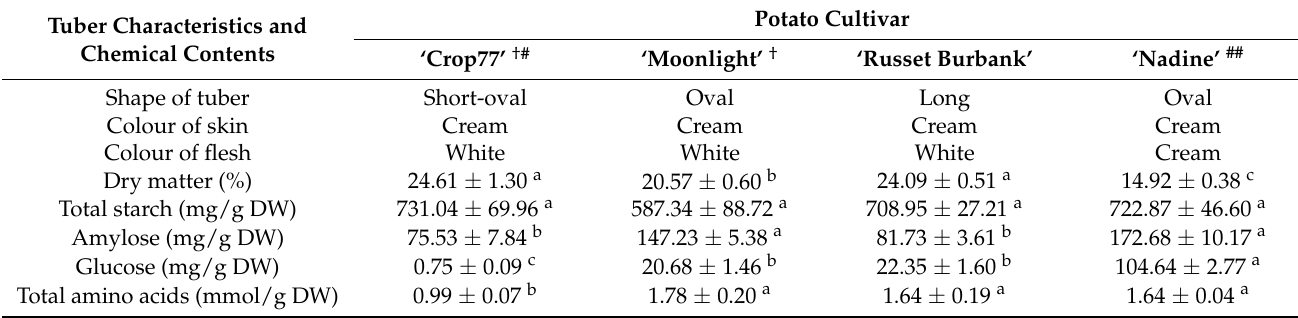
Table 1. Tuber characteristics, dry matter, total starch, amylose, glucose, and amino acid contents of ‘Crop77’, ‘Moonlight’, ‘Nadine’, and ‘Russet Burbank’ used in this study. Tuber Characteristics